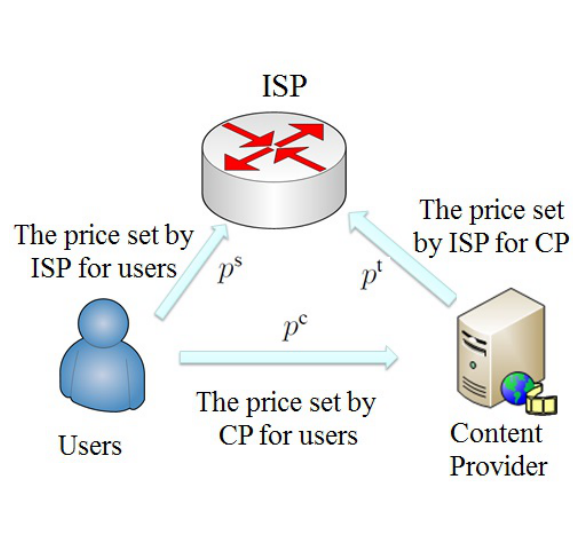
Figure 1: Money flow between ISP, CP and